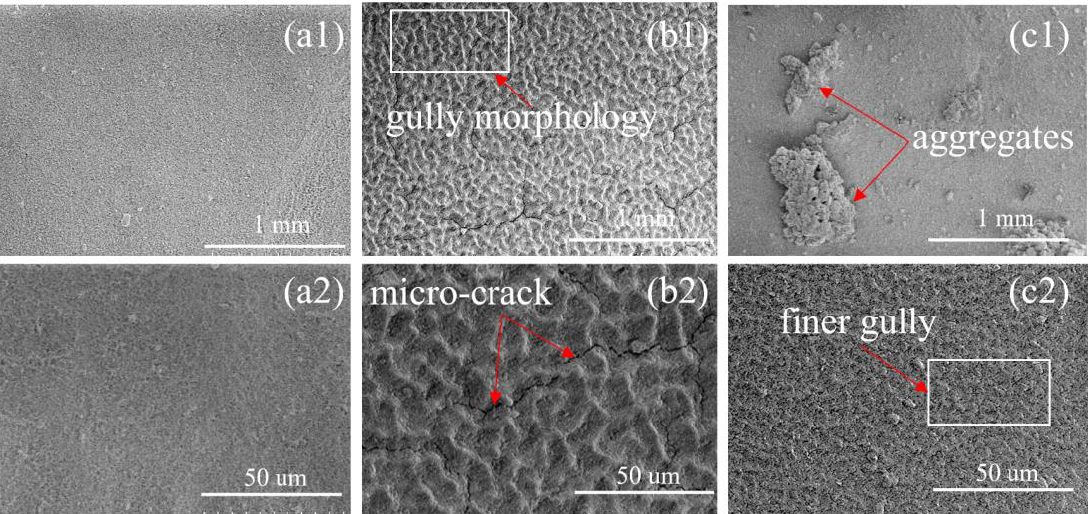
Figure 9. Surface SEM morphologies of the EPD 90 s coated magnet. ( a1 , a2 ) Without Mg 2+ and Cu 2+ ; ( b1 , b2 ) with Mg 2+ ; ( c1 , c2 ) with Cu 2+ .